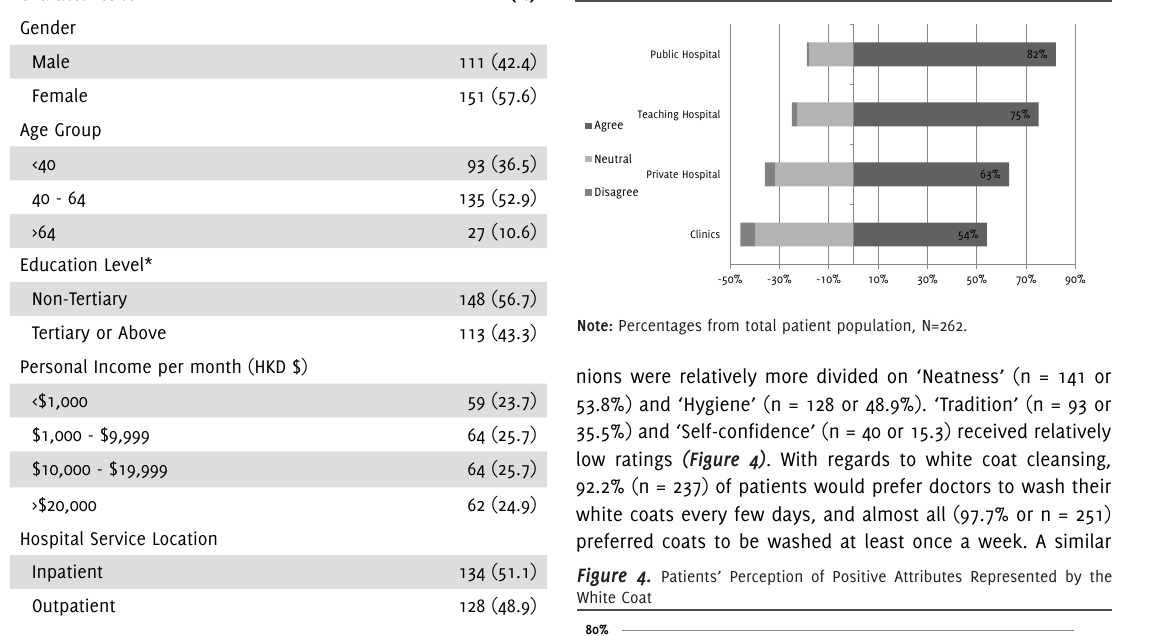
Note: Percentages from total patient population,